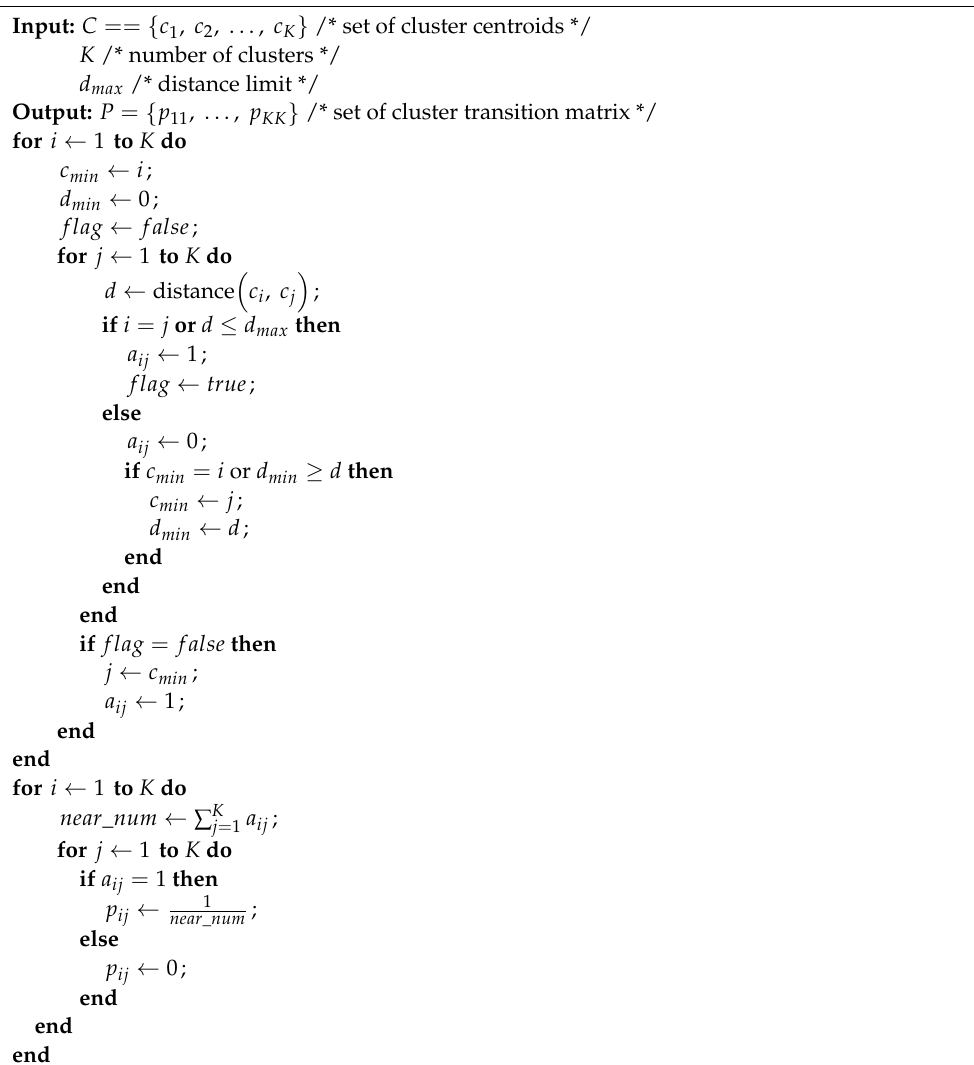
Algorithm 2 Cluster State Transition Matrix Generation